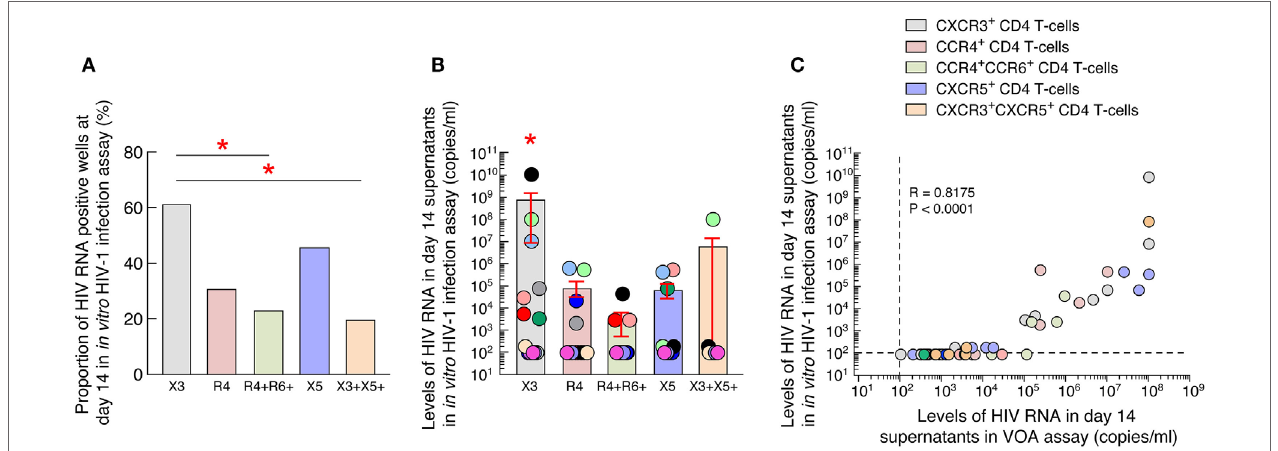
FigUre 4 | Blood CXCR3 + CD4 T cells of antiretroviral therapy (ART)-treated aviremic HIV-1-infected individuals represent the major source of infectious HIV-1 in blood. (a) Proportion of HIV-1-infected individuals with detectable HIV-1 RNA ( ≥ 200 HIV-1 RNA copies/mL) in the in vitro HIV-1 infection assay. (B) Levels of HIV-1 RNA in blood memory CD4 T cell populations at day 14 of in vitro HIV-1 infection assay ( N = 13). (c) Correlation between HIV-1 RNA levels measured in VOA and in in vitro HIV-1 infection assay in supernatants of blood memory CD4 T-cell populations ( N = 13). Undetectable values were arbitrarily defined as 100 HIV-1 RNA copies/mL (B,c) . Each individual is uniquely color coded in (B) . Each CD4 T-cell population is uniquely colored in (c) . Histograms correspond to mean (a,B) ; red bars correspond to SEM (B) . “X3” corresponds to blood CXCR3-expressing CD4 T cells; “R4” corresponds to blood CCR4-expressing CD4 T cells; R4 + R6 + corresponds to blood CCR4 + CCR6 + CD4 T cells; “X5” corresponds to blood CXCR5-expressing CD4 T cells; And X3 + X5 + corresponds to blood CXCR3 + CXCR5 + CD4 T cells. Red stars indicate statistical significance ( P < 0.05) (a,B) . Statistical significance ( P -values) was either obtained using two-tailed Chi-square analysis for comparison of positive proportions (a) or using one-way ANOVA (Kruskal–Wallis test) followed by Wilcoxon matched-pairs two-tailed signed rank test (B) or Spearman rank test for correlation (c)